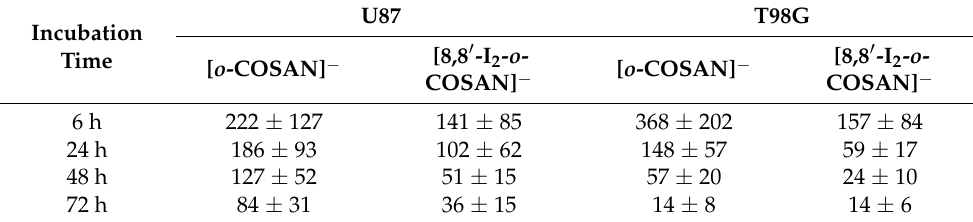
Table 2. IC 50 ( µ M) of [ o -COSAN] − and [8,8 (cid:48) -I 2 - o -COSAN] − towards U87 and T98G cells determined after 6, 24, 48, and 72 h of incubation. Data are mean ± SD.